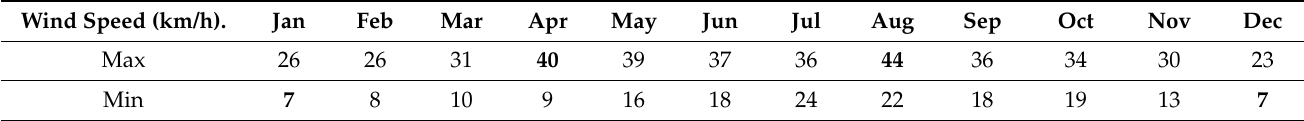
Table 2. Wind dynamics in Alexandria, monthly in 2021 (after https://www.timeanddate.com/ weather/egypt/alexandria/historic?month=12&year=2021, accessed on 23 May 2022). Wind Speed (km/h).